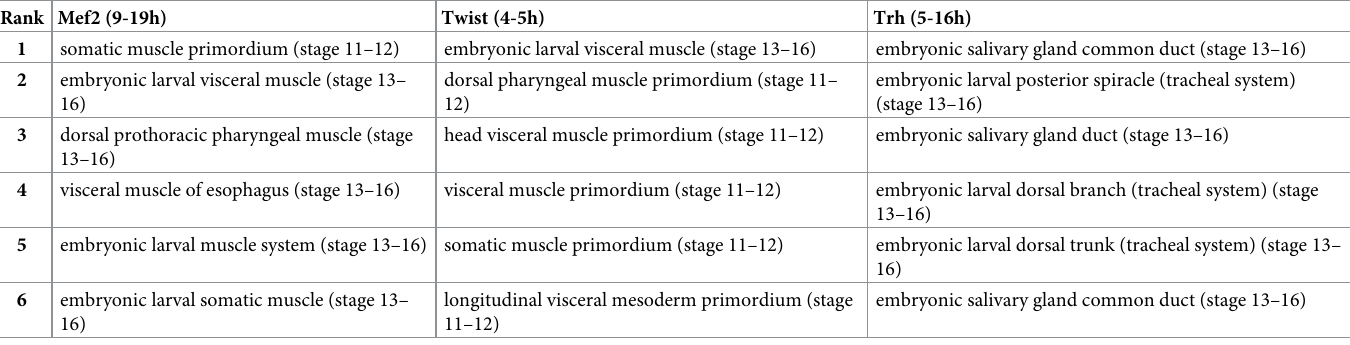
Table 1. Identification of relevant tissues from whole-embryo differential expression datasets.